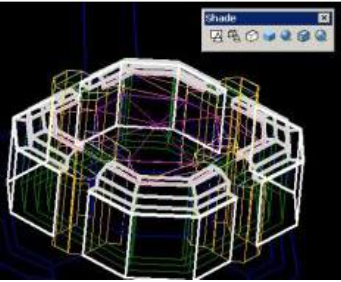
Figure 1. National Palace of Culture in Sofia - geometrical model created in AutoCAD